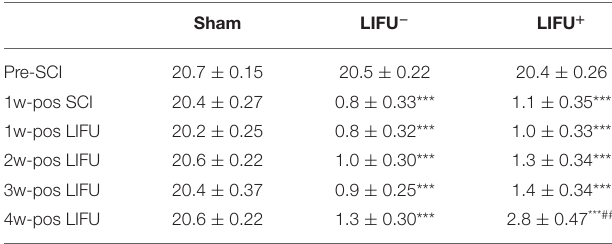
anti-rabbit IgG (H + L), F(ab ′ )2 fragment (Alexa Fluor R (cid:13) 488 Conjugate), and anti-mouse IgG (H + L), F(ab ′ )2 fragment